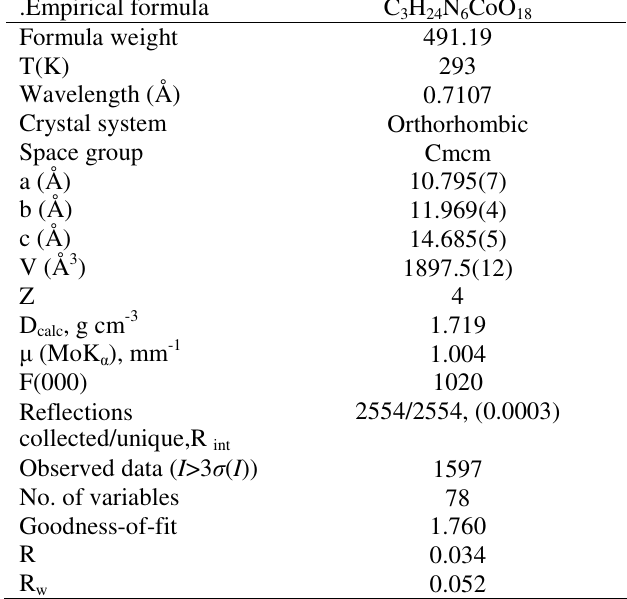
Table 1. Crystal data, experimental parameters used for the intensity data